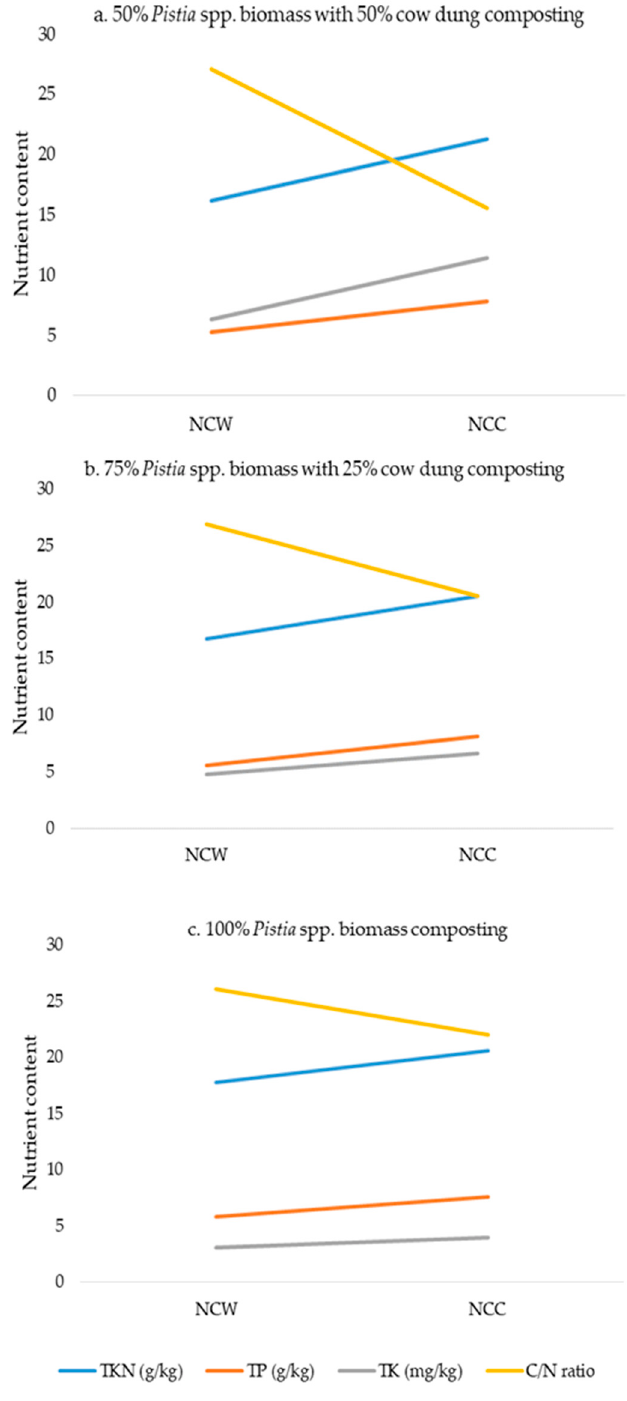
Figure 3. Chemical analysis of initial and composted waste mixtures produced by ( a ) 50% Pistia spp. biomass and 50% cow dung composting; ( b ) 75% Pistia spp. biomass and 25% cow dung composting; and ( c ) 100% Pistia spp. biomass composting [59]. Note: NCW—Nutrient content of weed sediment, NCC—Nutrient content of prepared compost. Methods which are used to measure TKN are the micro-kjeldahl digestion method, the method of ascolbic acid-reduced molybdophosphoric acid method for TP, and the flame photometer (Systronic 128) method for TK in Dehradun, India.